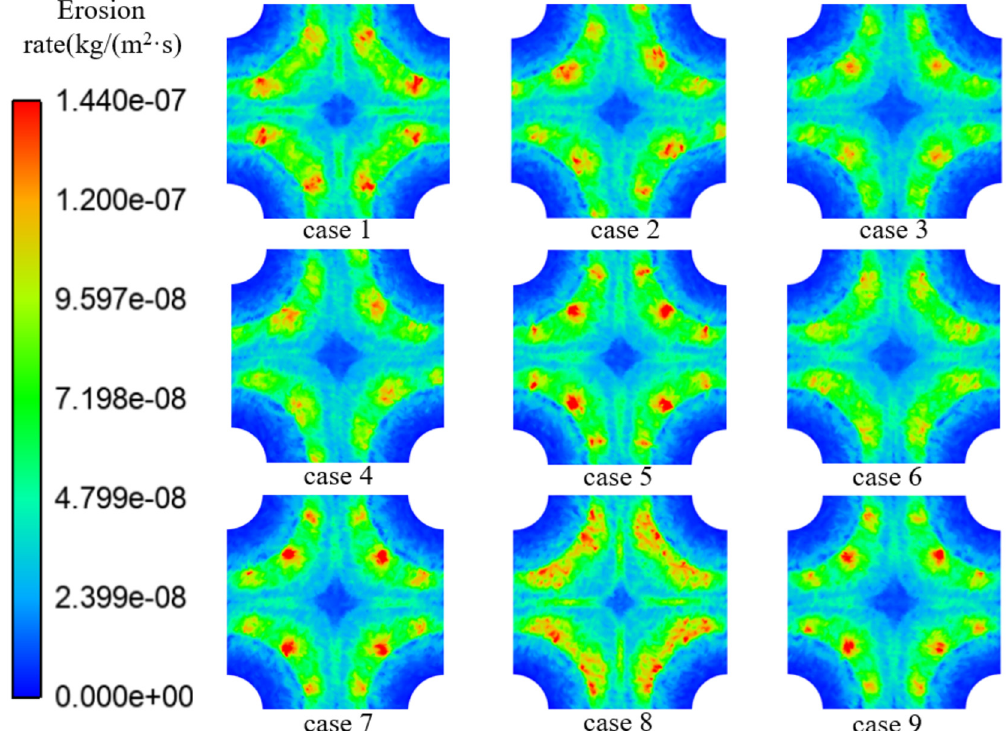
Fig. 13. Cloud diagram of the erosion rate distribution of the nine